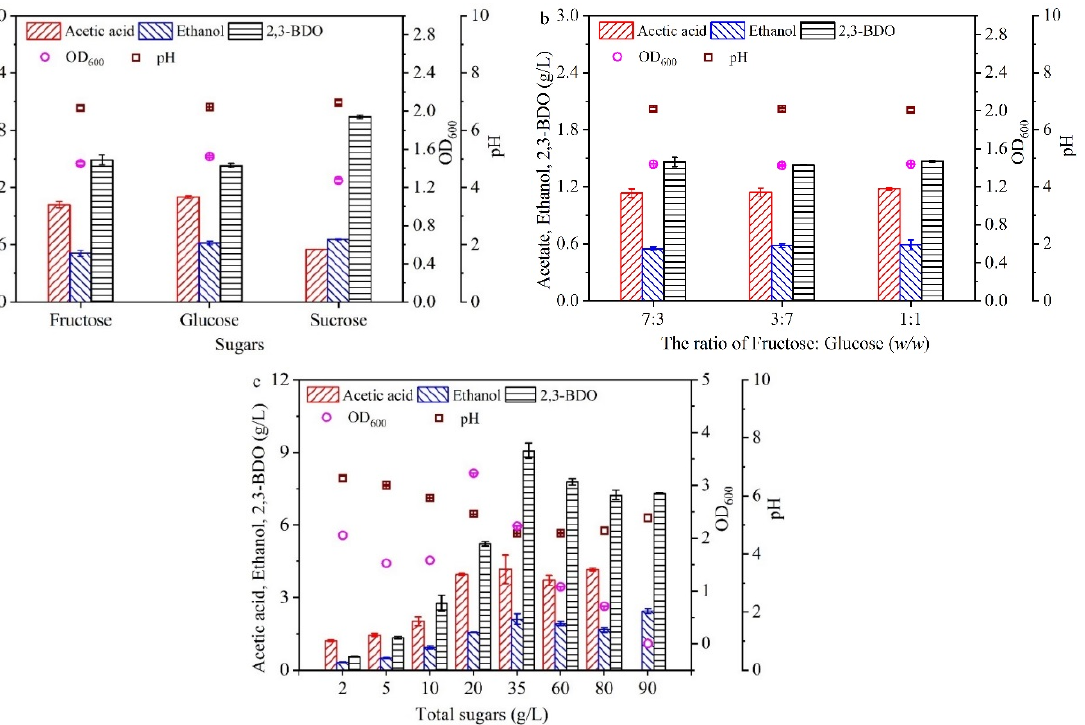
Figure 1. Effect of sugars ( a ), the ratio of fructose:glucose ( b ), and total sugars in molasses ( c ) on 2,3-BDO production. The basal medium was the same as the modified DSMZ 879 medium, while the sugar (i.e., fructose) was substituted by a different substrate in Figure 1. The fermentation was carried out in 250 mL screw-cap bottles. Data are given as the mean ± SD, n = 3.